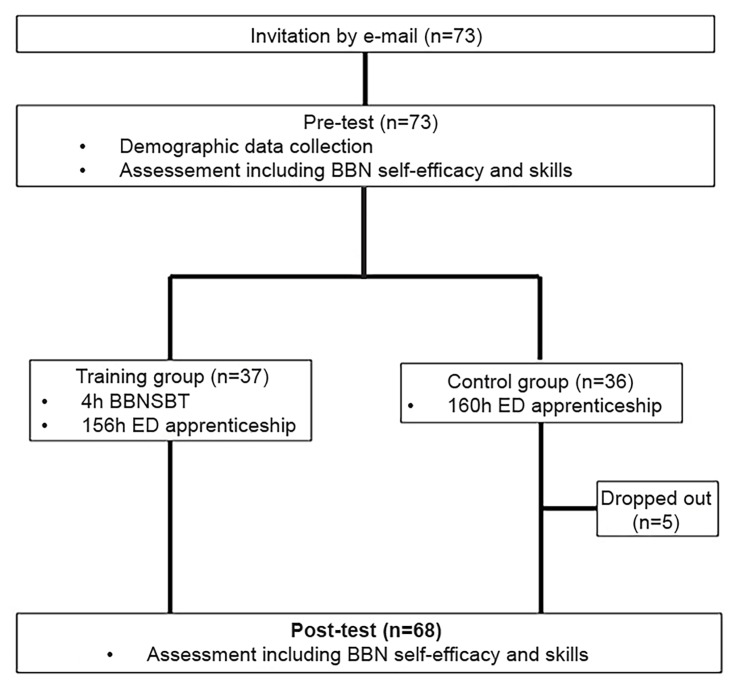
Flowchart of study examining the effect of simulation training on how trainees deliver bad news.BBN, breaking bad news; BBNSBT, BBN simulation-based training; h, hour; ED, emergency department.